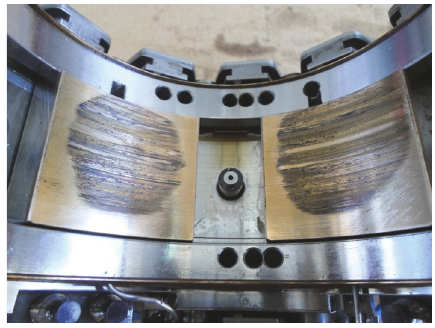
Figure 14: IGT inlet bearing showing vibration damage.